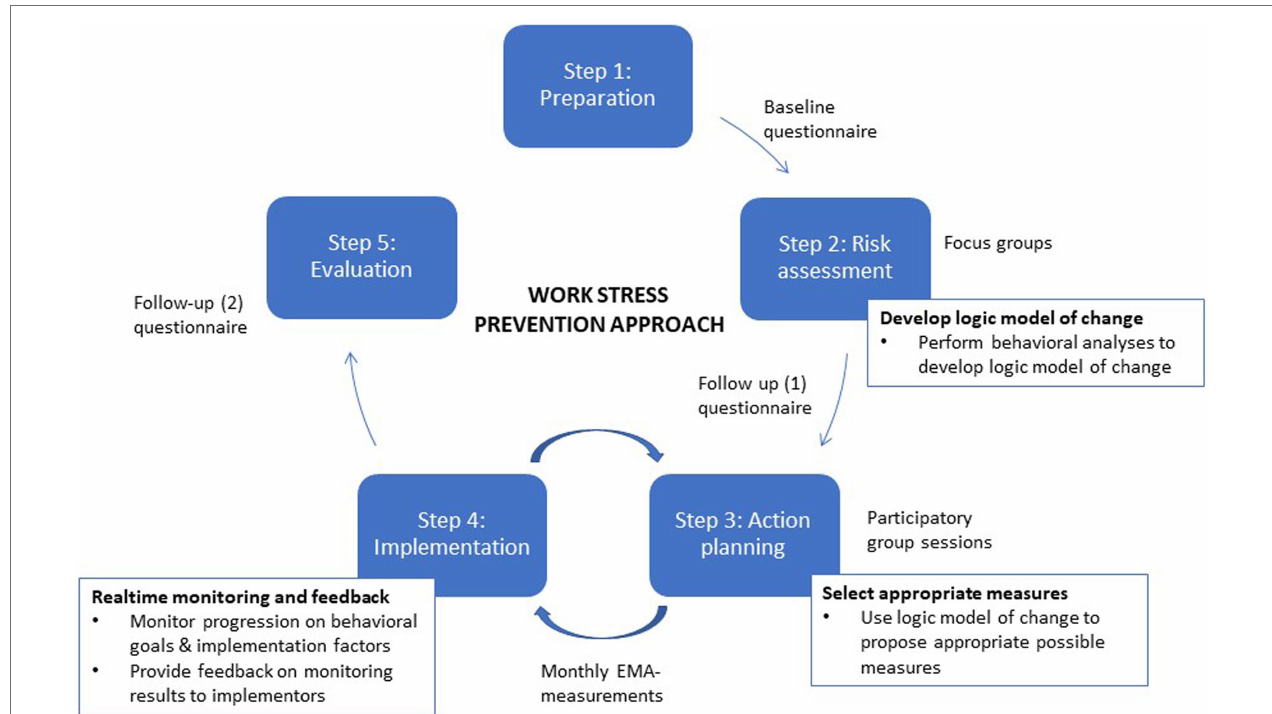
FIGURE 1 | Schematic overview of work stress prevention